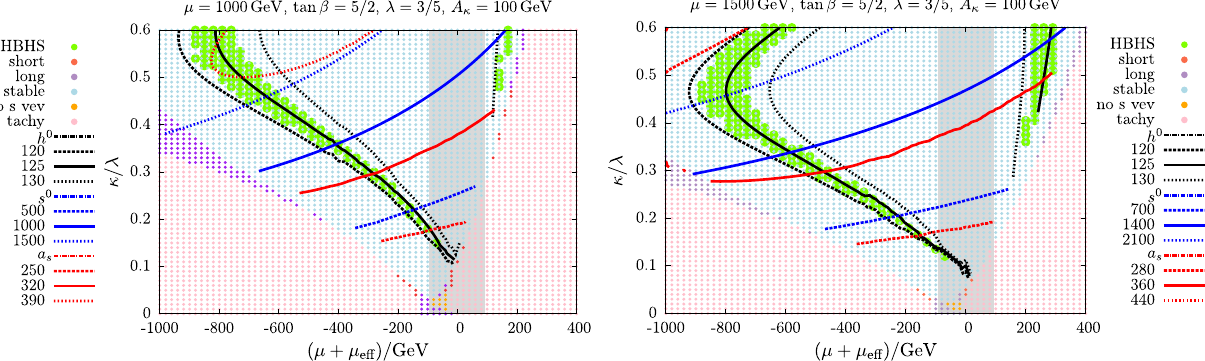
respectively, whereas blue points have a stable electroweak vacuum. Rose points are excluded because of tachyonic tree-level masses. The orange points cannot reproduce a non-vanishing μ eff at the electroweak vacuum via the constraint of Eq. (23). With the gray vertical band we mark a naïve direct experimental exclusion bound from the chargino mass m χ ± > 94GeV. Green areas are allowed by HiggsBounds and HiggsSignals (indicated as “HBHS” in the legend)